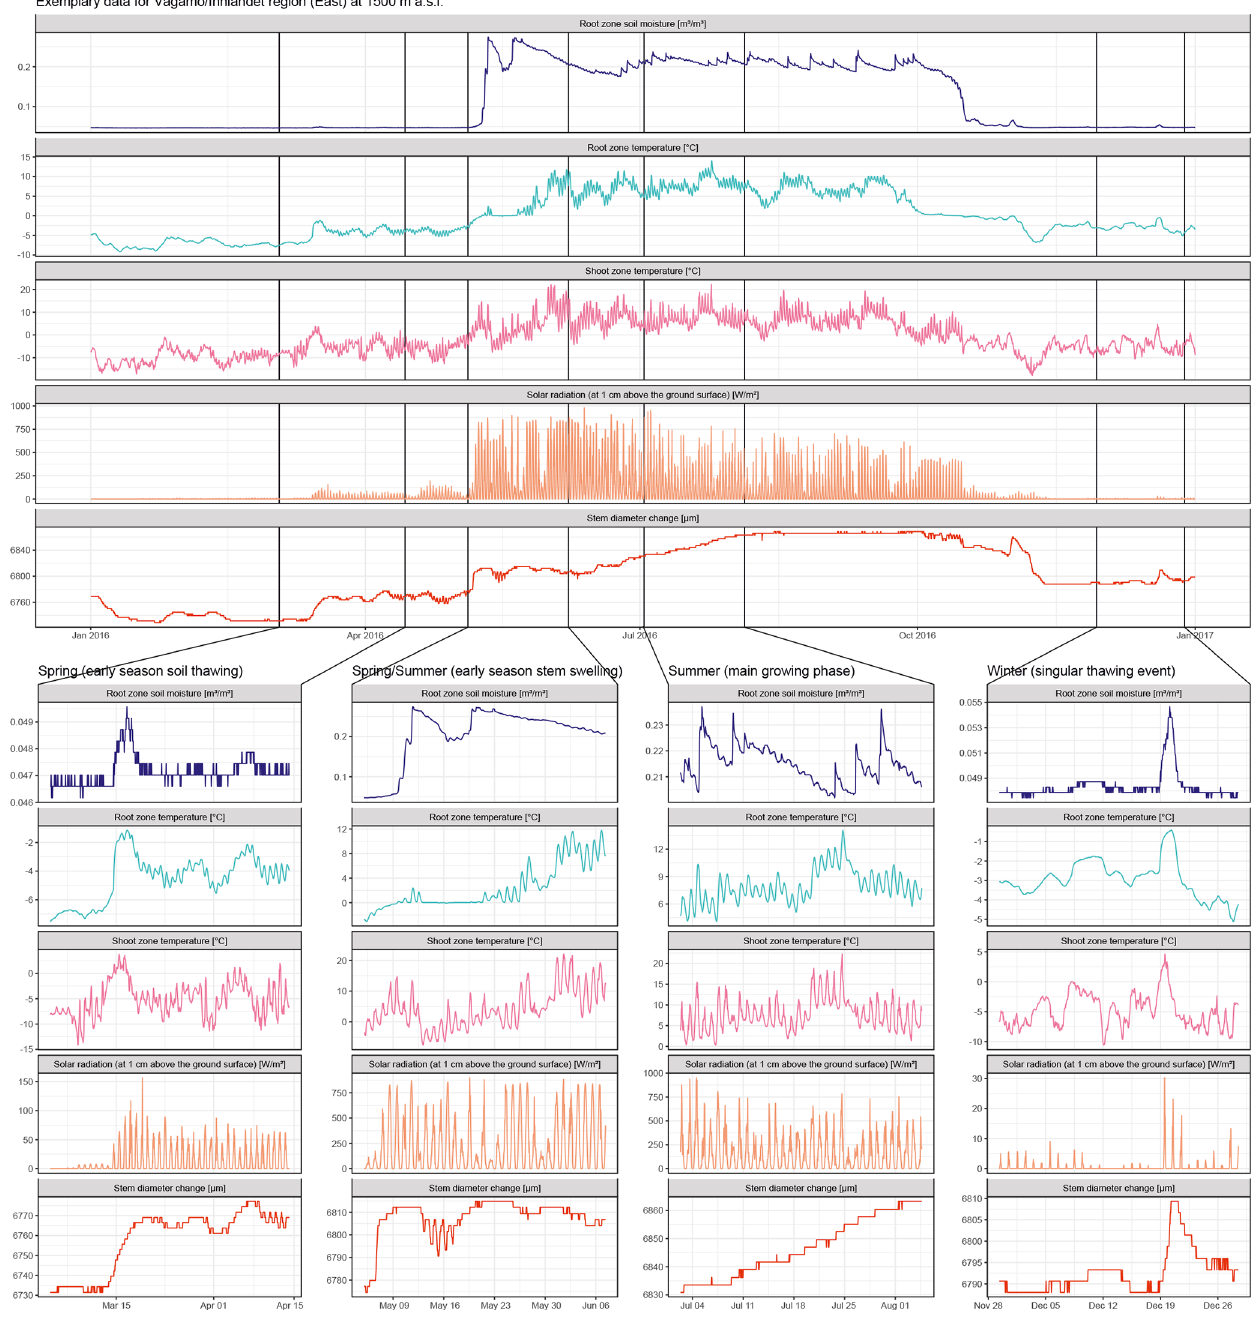
Figure A8. Raw data for one exemplary specimen from the Vågåmo, Innlandet, region at 1500ma.s.l. Here, we present hourly data of stem diameter variability and the respective micro-environmental conditions. The four sections show important phases of the annual stem diameter variability and their relation to the micro-environment in detail. Coupling of soil moisture and stem diameter during the winter and spring months, when water-induced stem swelling and shrinking occur and decoupling during the main growing phase is clearly evident. Additionally, the direct response of the stem diameter to singular soil thawing events in winter is clearly visible in the curves.